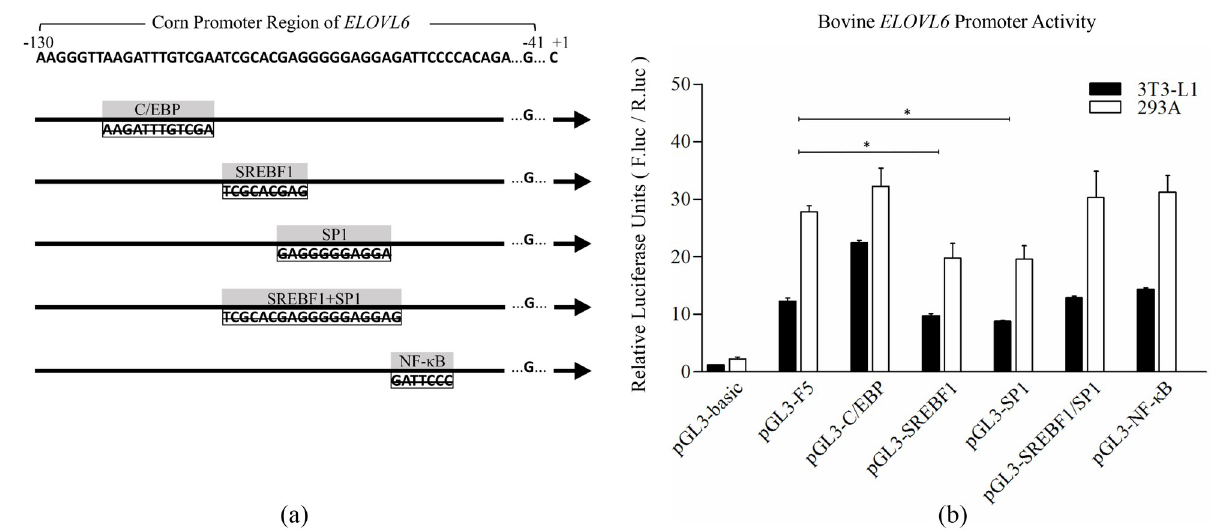
Fig 5. Luciferase activities of different deletion constructs. ( a ) Schematic represented various deletionconstructs in the core regionof bovine ELOVL6 promoter. The transcription initiationsite was designatedas +1.; ( b ) Luciferase activitiesof different deletionconstructs were indicatedas mean ± SD of the independent experiment performed in